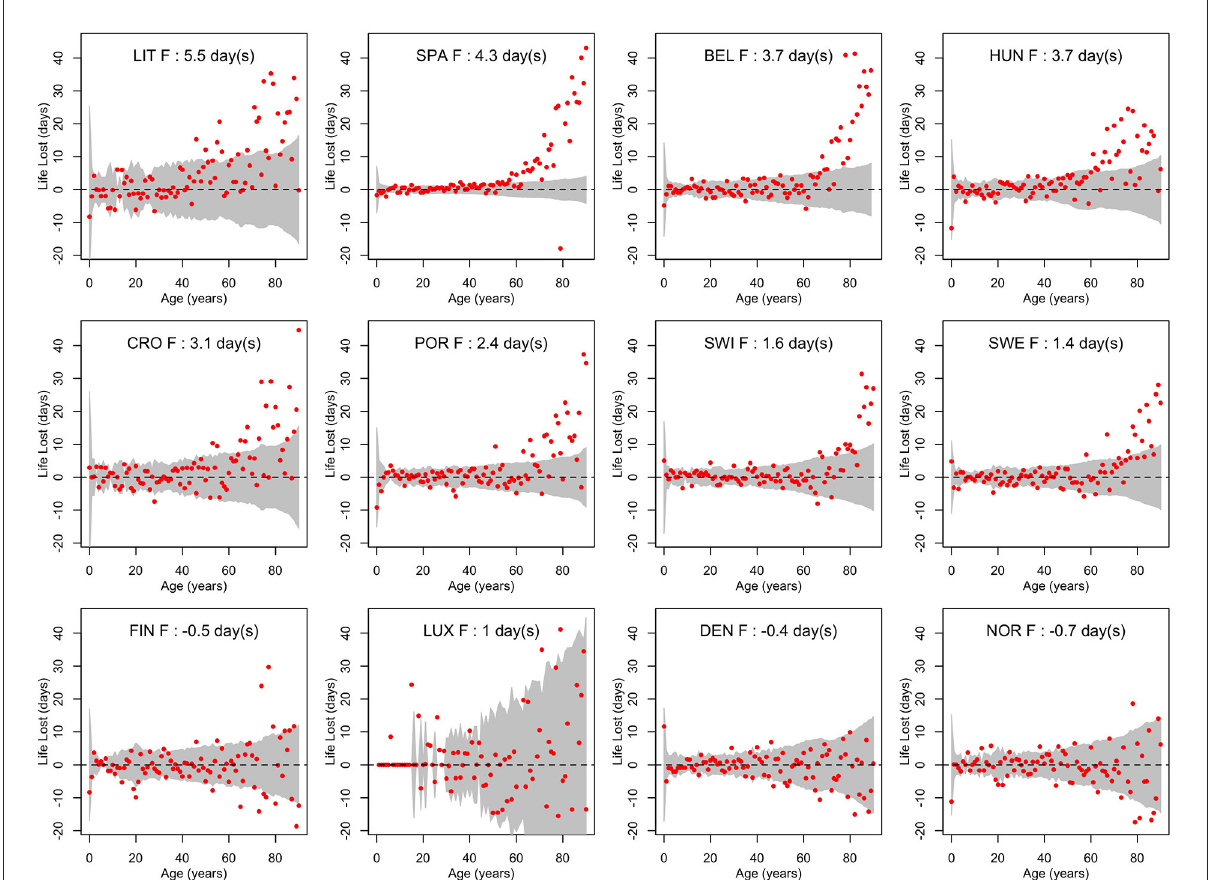
FIGURE4 Life losses in 2020 ( L 2020 x ) at ages x between 0 and 90 for women (F) of 12 European countries, together with 95% prediction intervals calculated under the null hypothesis of a similar mortality as the year before. At the top, population life loss in 2020 ( PLL 2020 , expressed in days) calculated as weighted average of life losses at the different ages x is